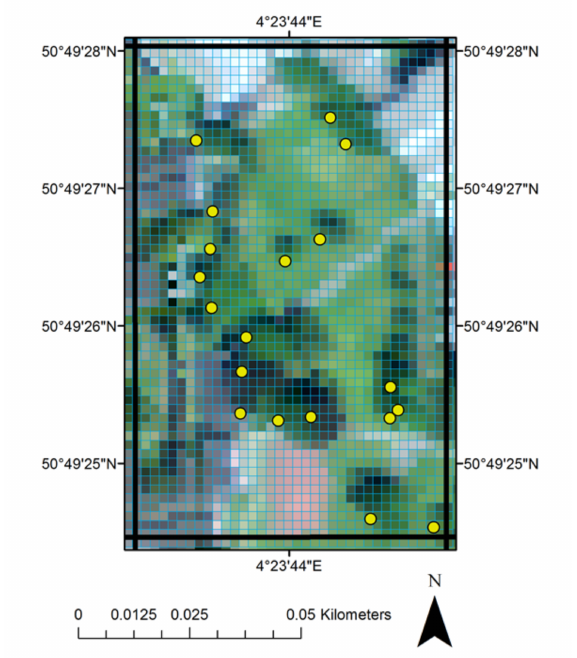
Figure 2. Selected Proba-V pixel with 18 monitored trees (yellow dots). The Proba-V pixel is delineated by the black lines (110 × 70 m), whereas the APEX pixels are delineated with blue lines (2 × 2